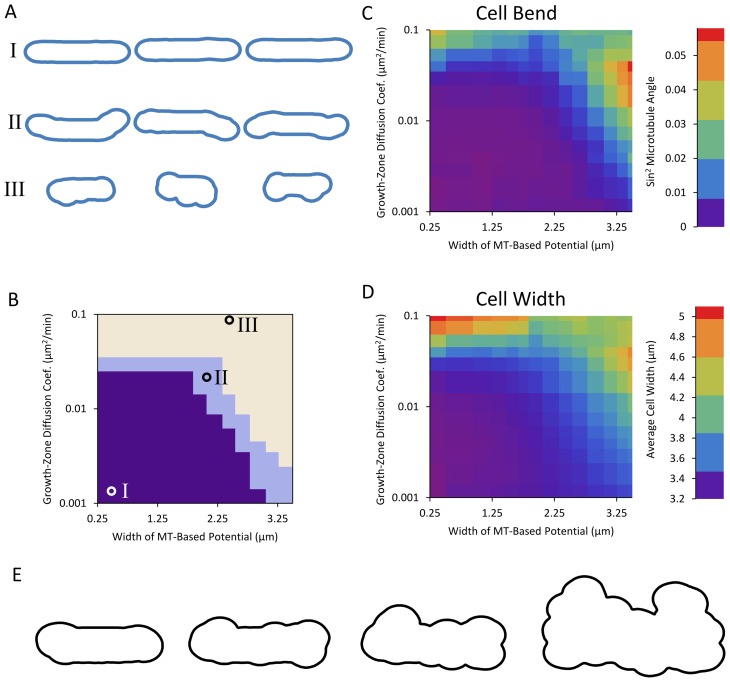
Two-dimensional qualitative model with two growing tips generates three families of shapes.
A–D. Same as Fig. 7, but with two growing tips. E. Evolution of bulged cell (parameters indicated by circle for region III) with two diffusing growth zones at long times. Model evolved for (going right) one, two, three, and ten times the amount of time necessary for a straight-growing cell to double.